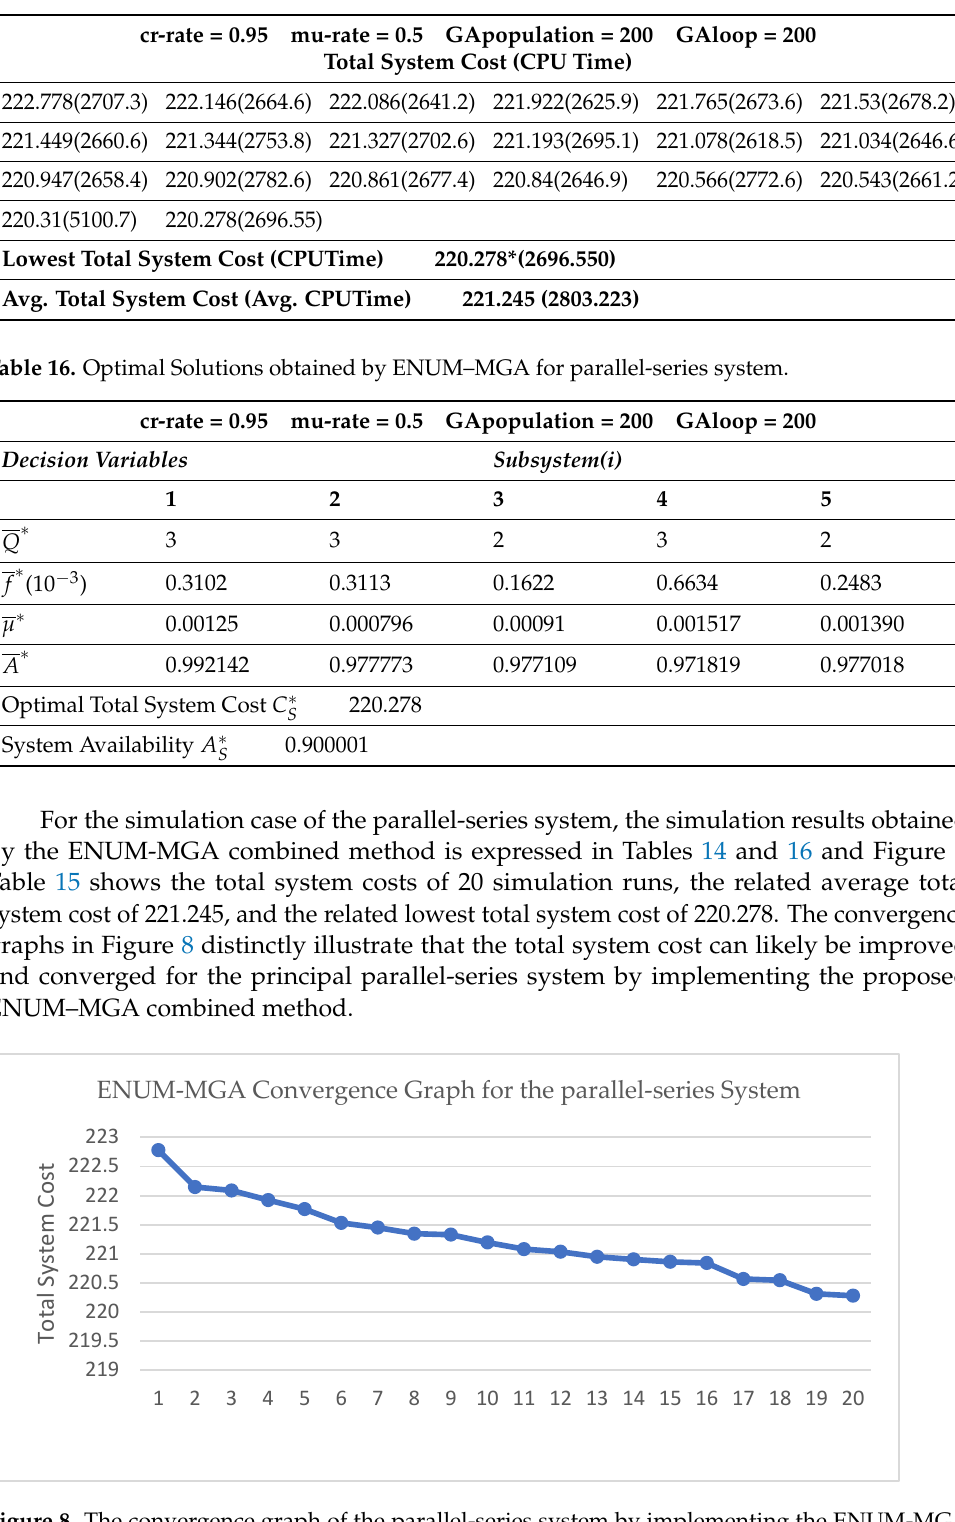
Table 15. The total system costs of 20 simulation runs obtained by ENUM–MGA for the parallel series system.